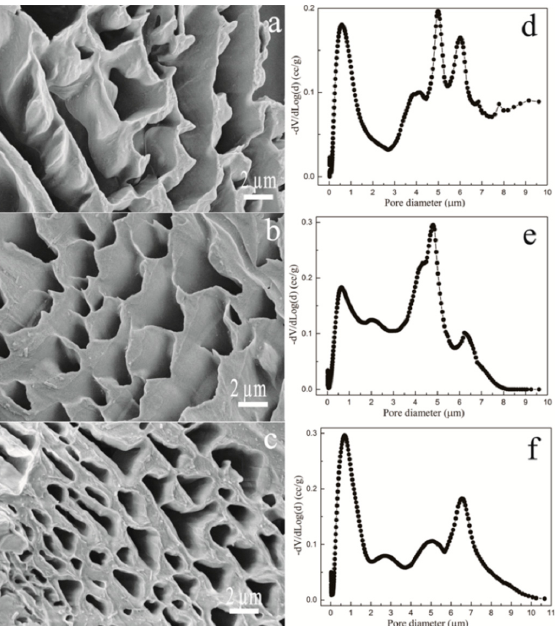
Figure 3. Pore surface morphology of P407 matrix hydrogel, PC160 ( a ) (5000×); PC200 ( b ) (5000×) and PC240 ( c ) (5000×); and the corresponding pore size distribution for PC160 ( d ); PC200 ( e ) and PC240 ( f ).